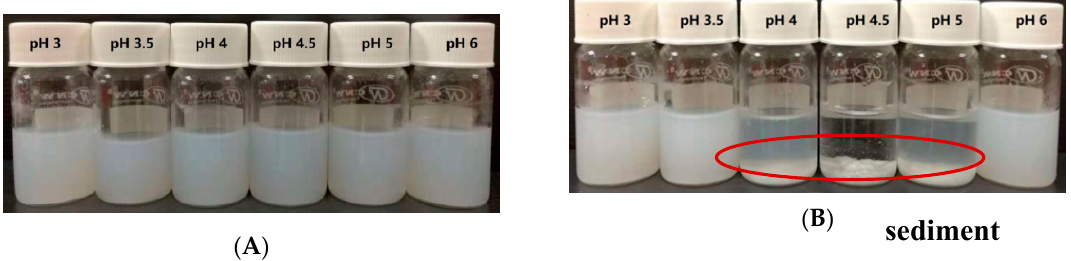
Figure 2. Visual appearance of zein-caseinate-pectin particles ( A ) and zein-caseinate particles ( B ) at di ff erent acidic pH